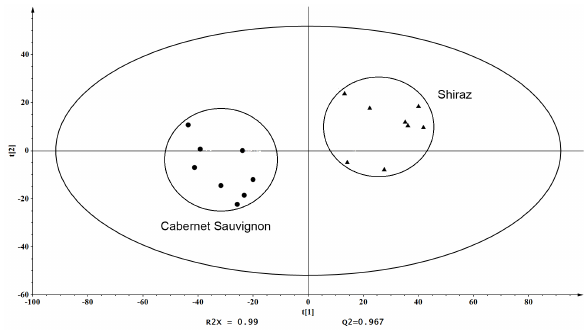
Figure 2: PCA scores plot based on the 1 H NMR spectra of Cabernet Sauvignon and Shiraz dry red wines. Black solid circles and black solid triangles represent Cabernet Sauvignon and Shiraz dry red wines samples, respectively.